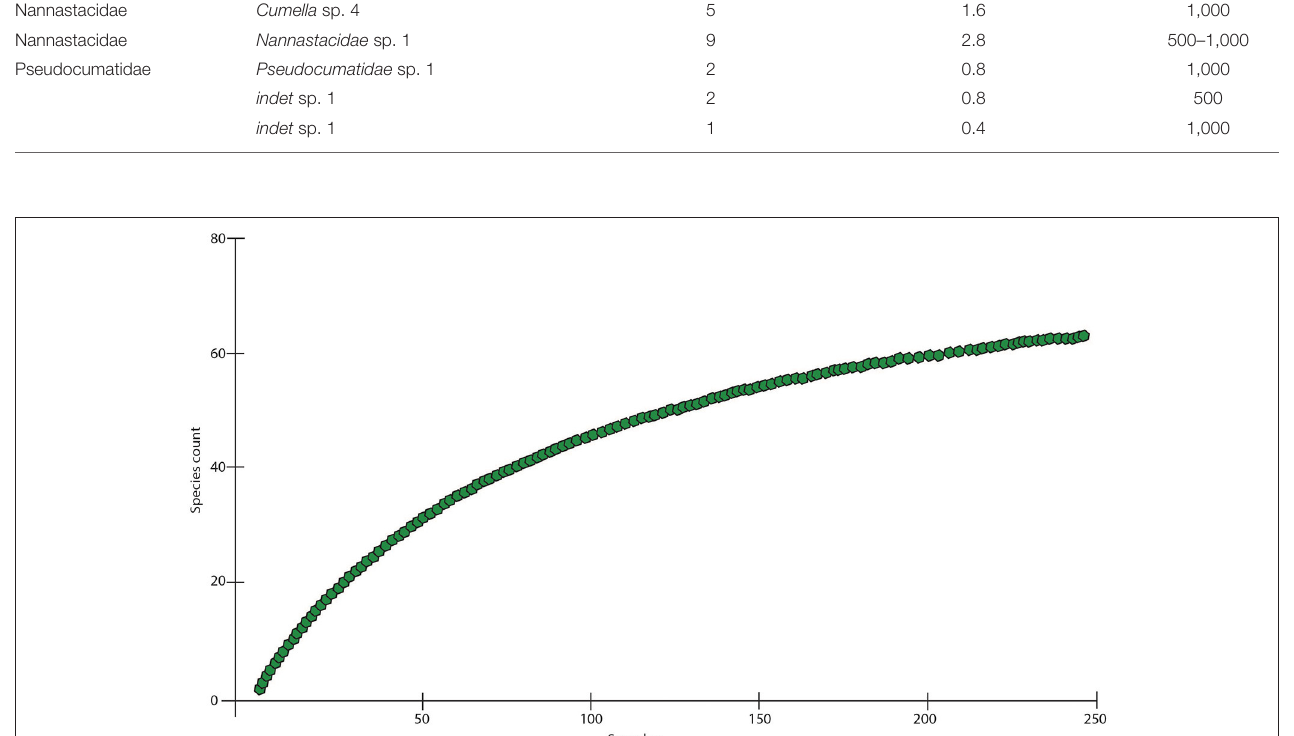
FIGURE 3 | Species accumulation curve for cumacean fauna sampled at the Gulf of Guinea.